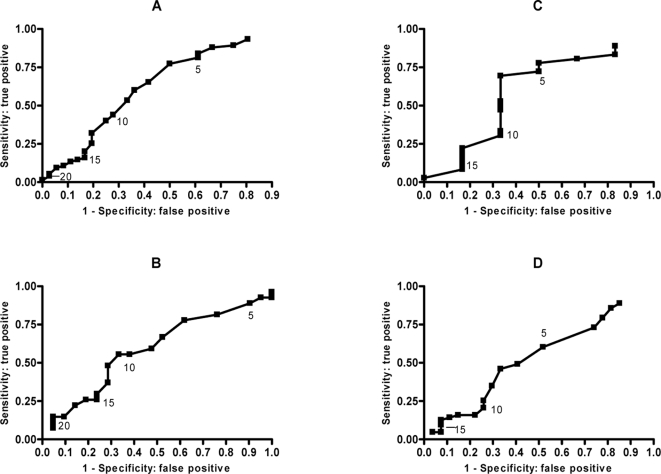
Receiver Operator Curves for Common Cold Score and Virus Result.A: CCQ (all asthma); B: CCQ (adults); C: CCQ (children); D: CCQ (excl chest symptoms).